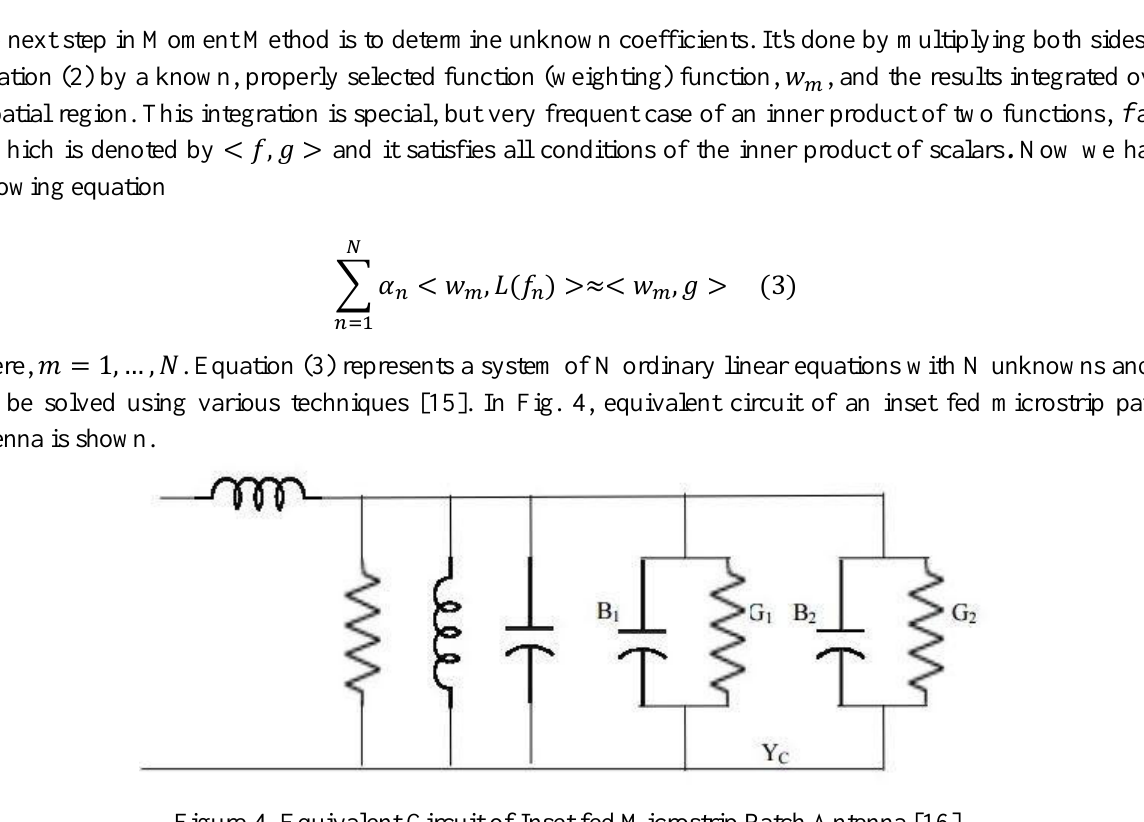
Figure 4. Equivalent Circuit of Inset fed Microstrip Patch Antenna